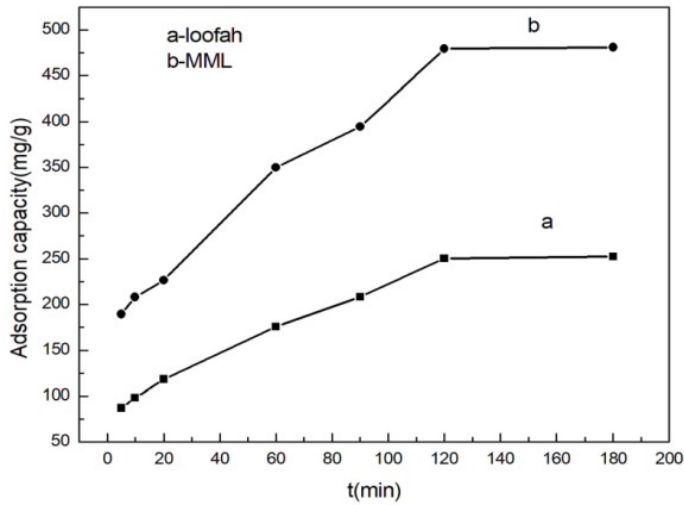
Figure 7. Relationship between adsorption capacity and adsorption time.